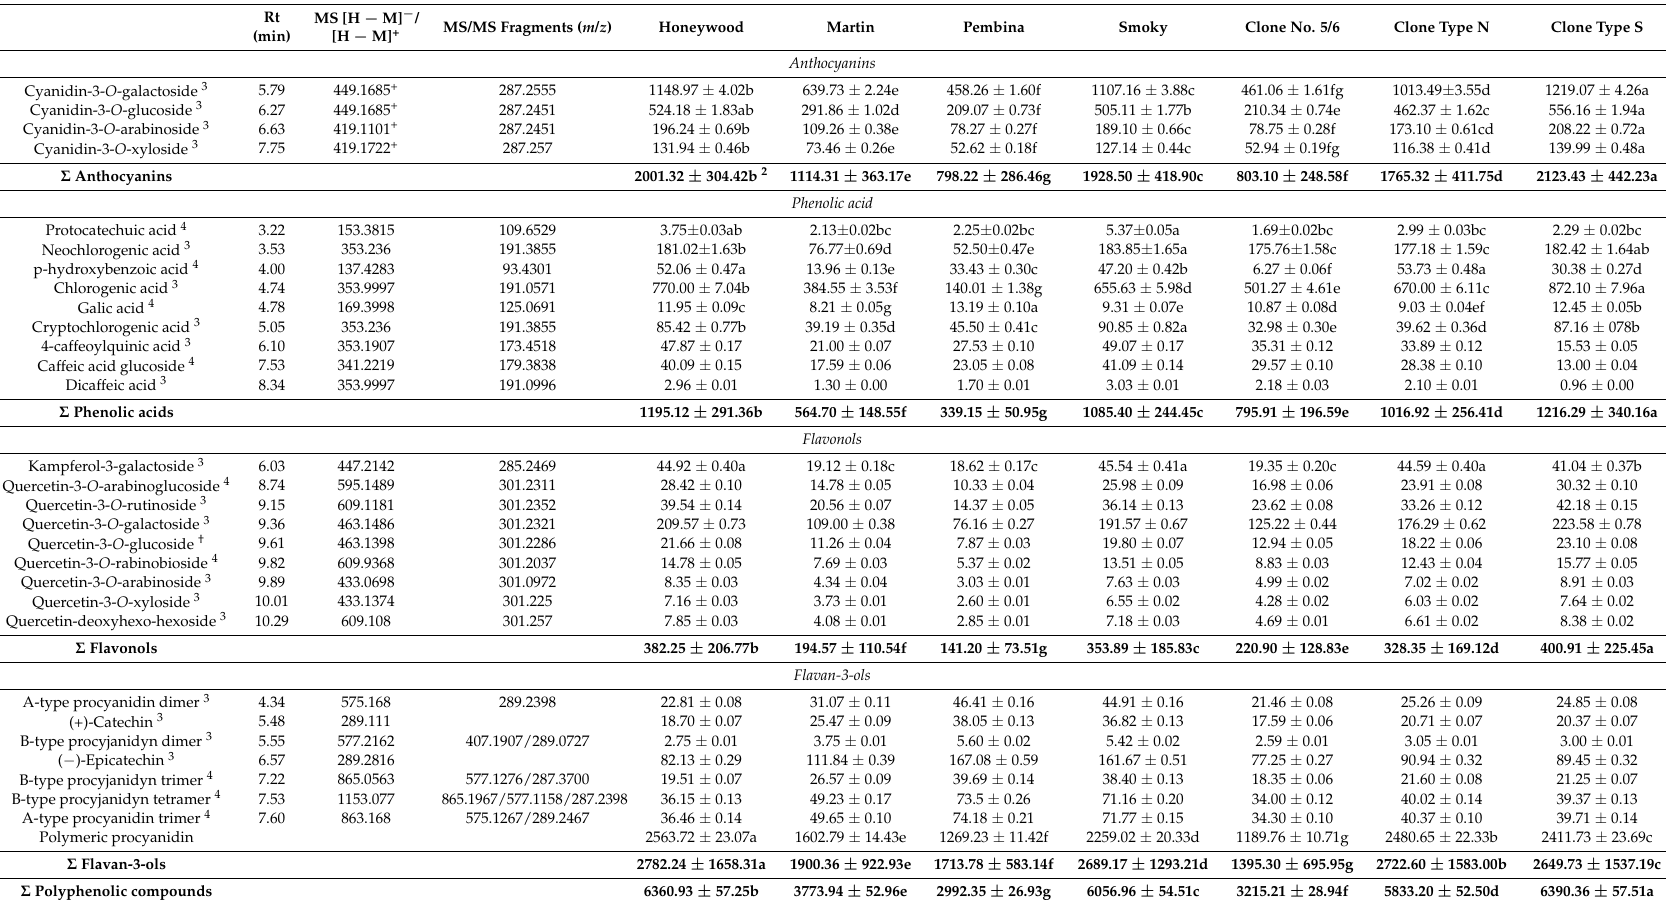
Table 2. The content of polyphenolic compounds (mg/100 g · dm) 1 of fruits in Saskatoon berry genotypes analyzed in